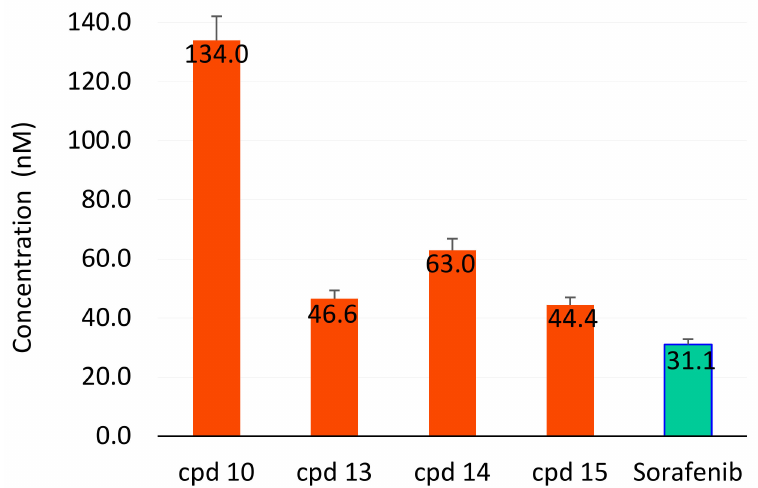
Figure 6. IC 50 of compounds 10 , 13 – 15 (compared with sorafenib) as inhibitors to the angiogenic VEGFR2 enzyme compared with sorafenib. Green color shows the lowest